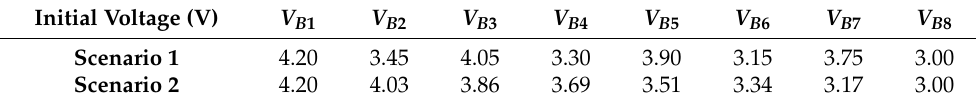
Table 3. Two simulation scenarios for different ICs.